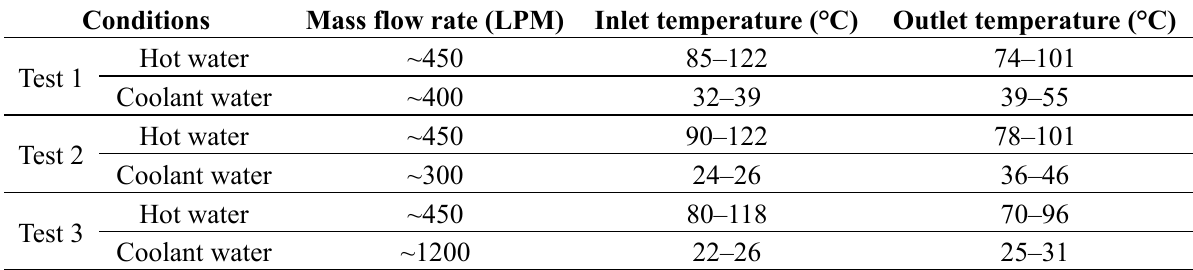
Table 2. Conditions of hot water and coolant water used in the three